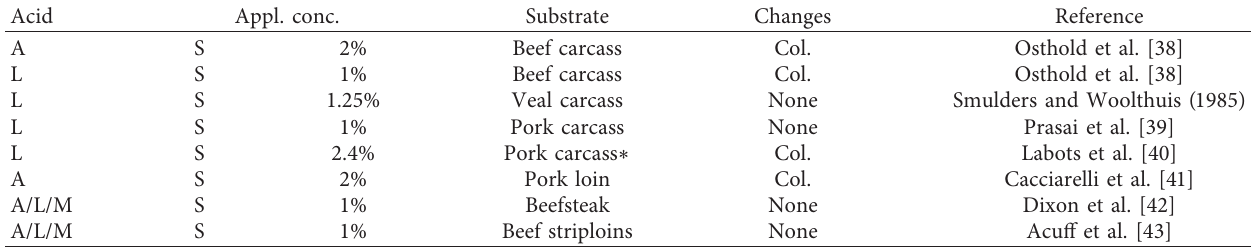
Table 1: Effects on meat quality traits by lactic and/or acetic acid application [35–37]. Acid Appl. conc.